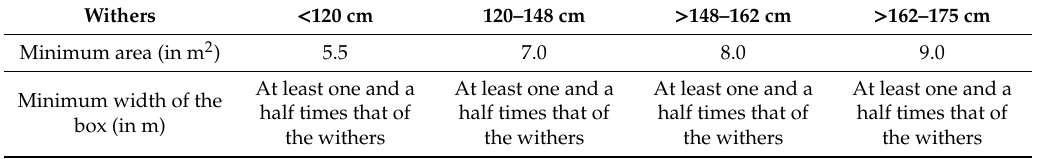
Table 8. Minimum measurements for individual boxes.